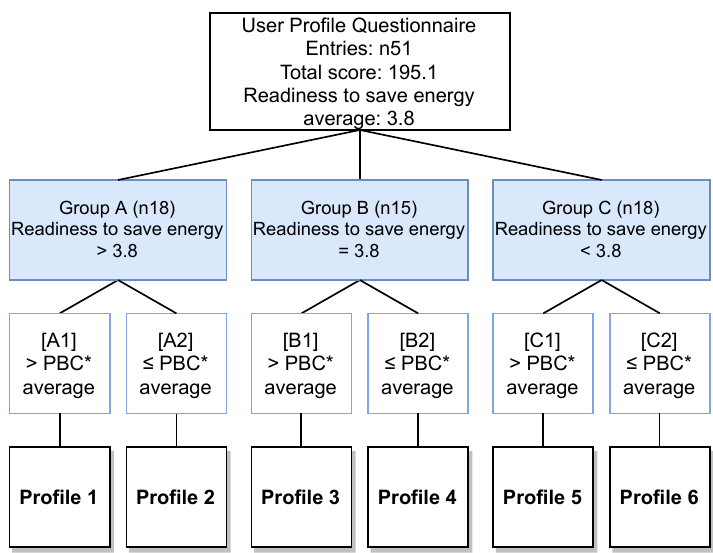
Figure 9. User profiling decision tree using 51 respondents as example.